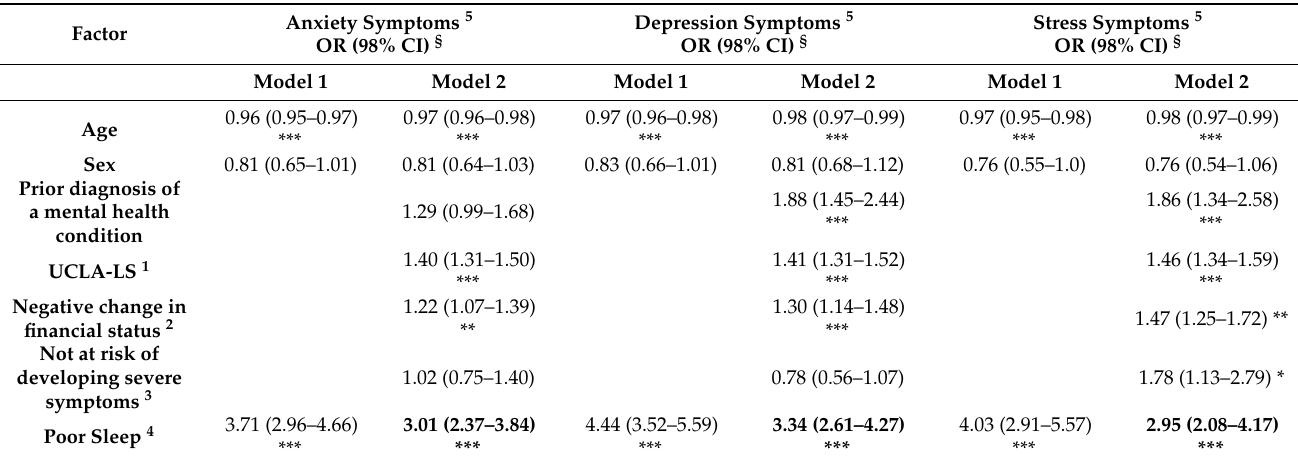
Table 3. Binary logistic regression examining the links of personal characteristics, pandemic and sleep-related factors with the severity of anxiety, depression and stress symptoms (based on cut-offs of each